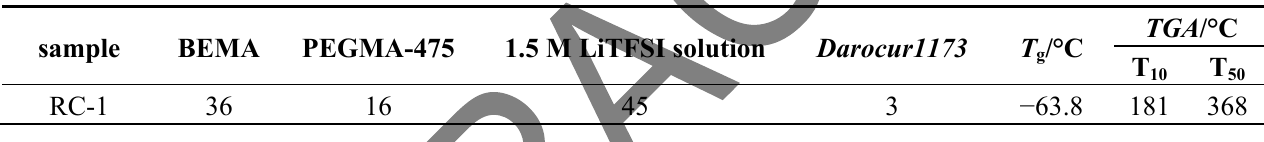
Table 1. Exact compositions (in wt.%) of the reactive mixture used to prepare sample RC-1, along with its thermal